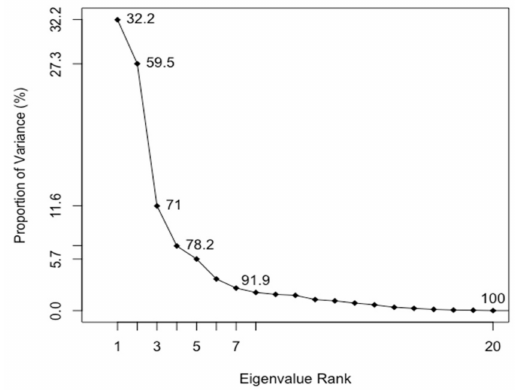
Figure 4. Scree plot. The cumulative variance accounted for by Principal Components. The eigenvalue rank represents the PC